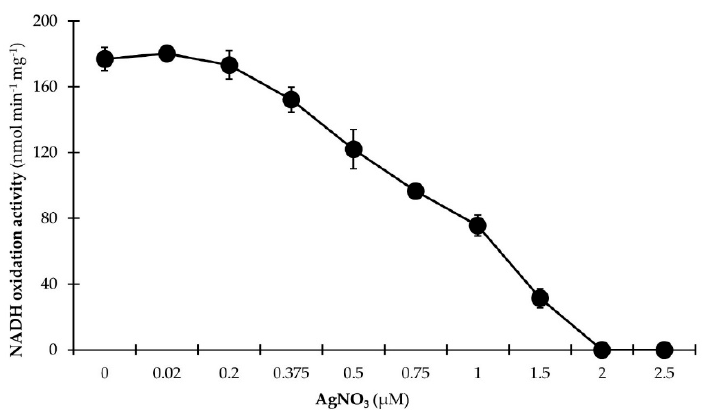
Figure4. Ag + inhibitsNADH:quinoneoxidoreductionactivityof P.bryantii B 1 4membranes. Membranes Figure 4. Ag + inhibits NADH:quinone oxidoreduction activity of P. bryantii B 1 4 membranes. prepared in chloride-free bu ff ers (aliquots of 150 µ g protein) were incubated with varying amounts of Membranes prepared in chloride-free buffers (aliquots of 150 µg protein) were incubated with AgNO 3 (0–2.5 µ M) for 5 min at 4 ◦ C. Membrane aliquots were added to the reaction bu ff er (20 mM varying amounts of AgNO 3 (0–2.5 µM) for 5 min at 4 °C. Membrane aliquots were added to the reaction buffer (20 mM Tris H 2 SO 4 , 5 % glycerol, 50 µM Na 2 SO 4 , 150 µM NADH, 100 µM ubiquinone-